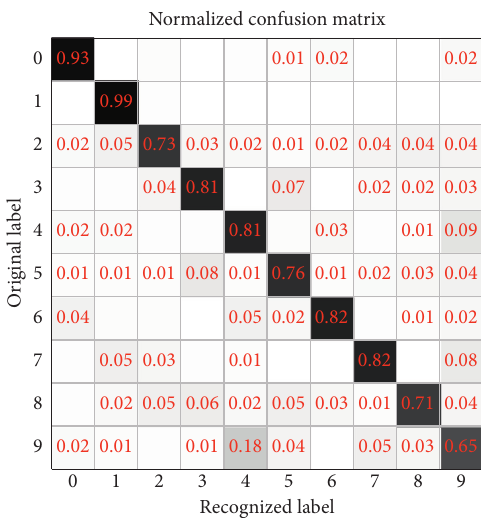
Figure 12: Performance of Implicit Recognition Model. Each column of the matrix represents the instances in an original class while each row represents the instances in a recognized class. The figure is accurate to two decimal places.